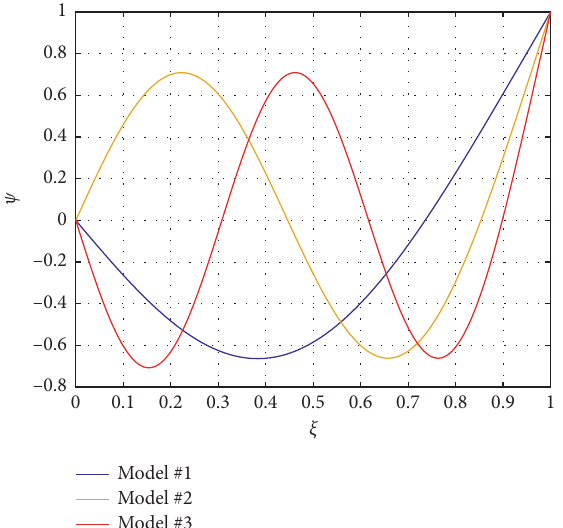
Figure 3: First three mode shapes of the flexible link.